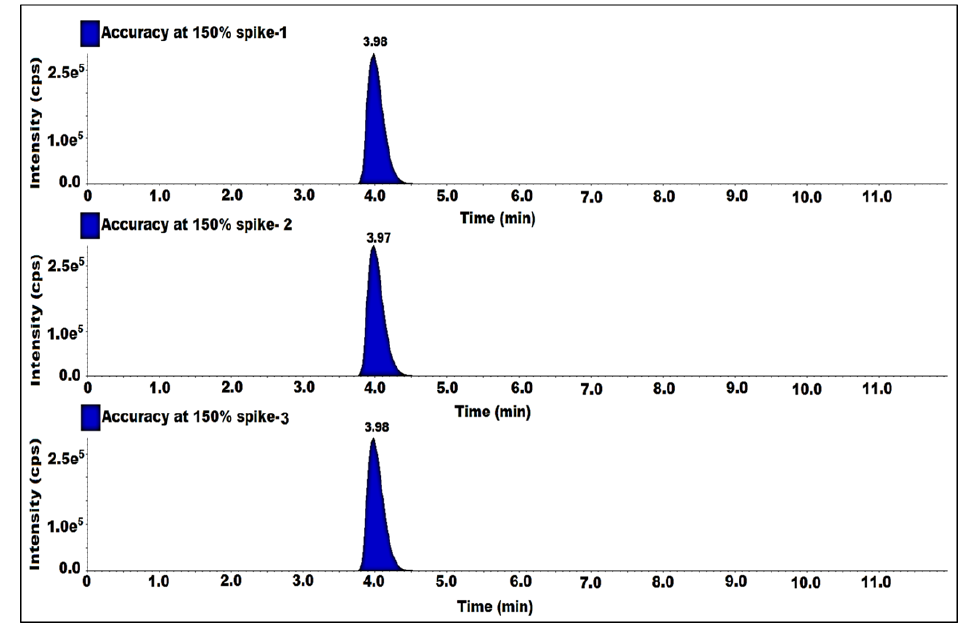
Figure 7. MS/MS MRM chromatogram of accuracy at 150% solutions.